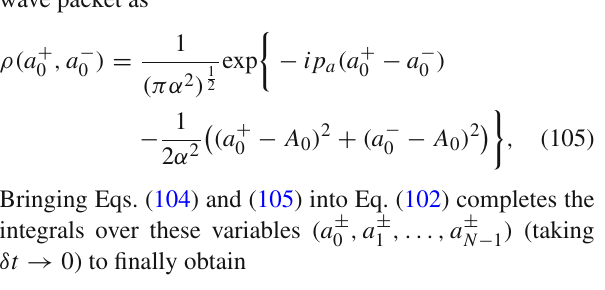
Fig. 21 Variations in the quantum fluctuation versus the coherence. The horizontal axis represents the coherence. The parameters are taken as: p a = 1, α = 1, V 0 =